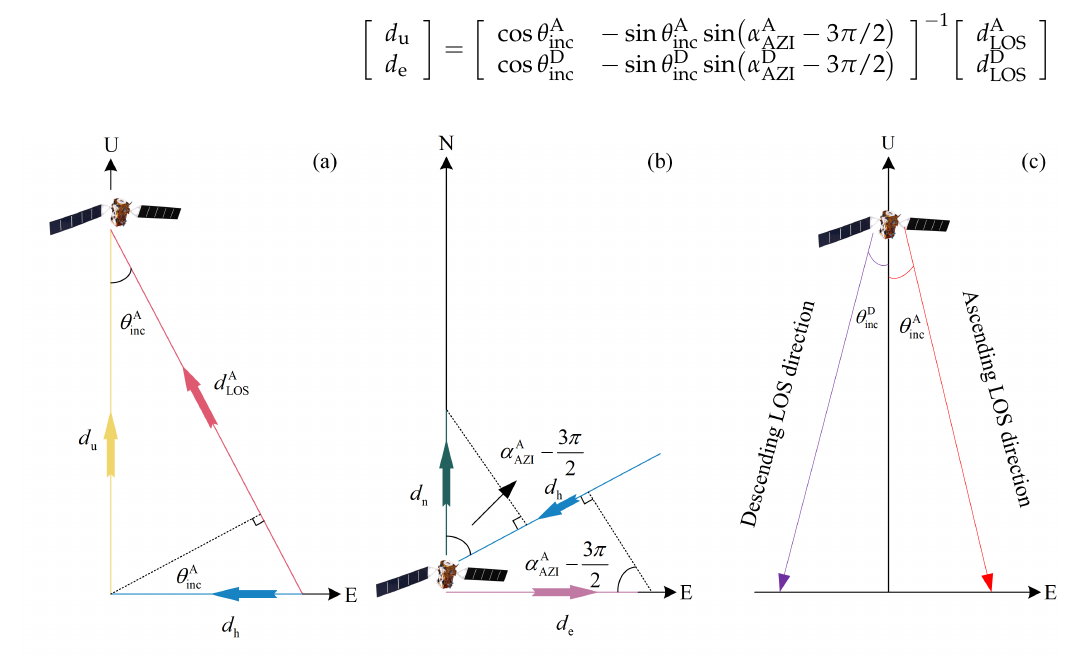
Figure 2. Geometric relationship of the LOS direction from ( a ) the horizontal perspective and ( b ) the vertical perspective in the Sentinel-1A ascending orbit mode, as well as ( c ) the imaging geometry of ascending and descending